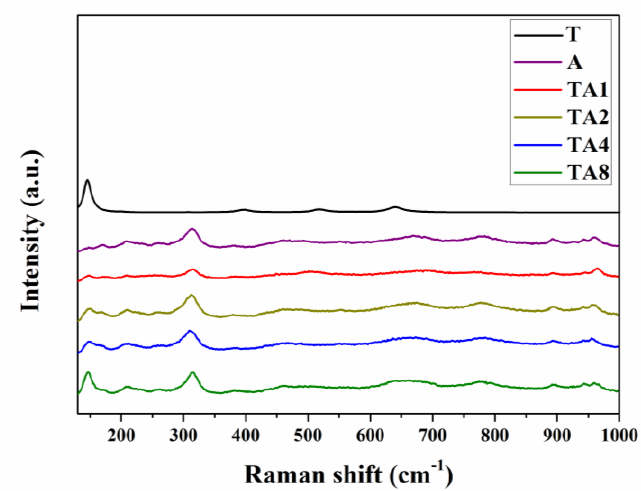
Figure 3. Raman spectra of T, A, TA1, TA2, TA4, and TA8 samples, respectively.